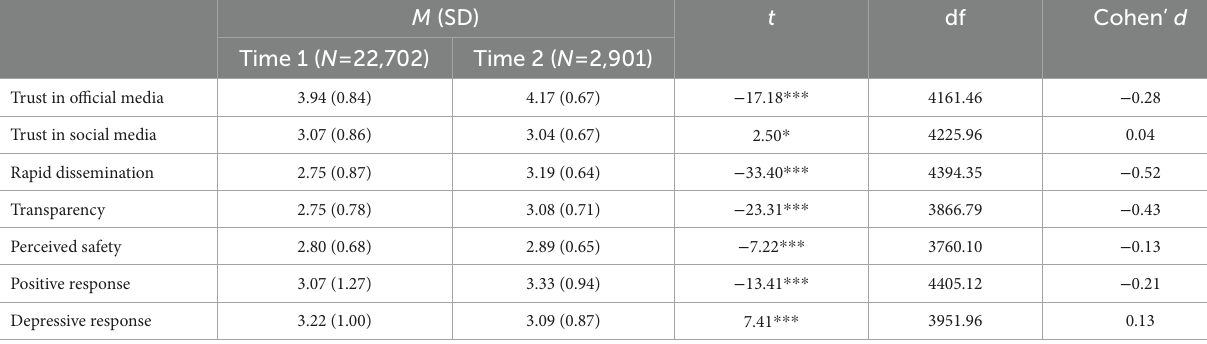
TABLE 2 Descriptive statistics and independent samples t -test results for measured